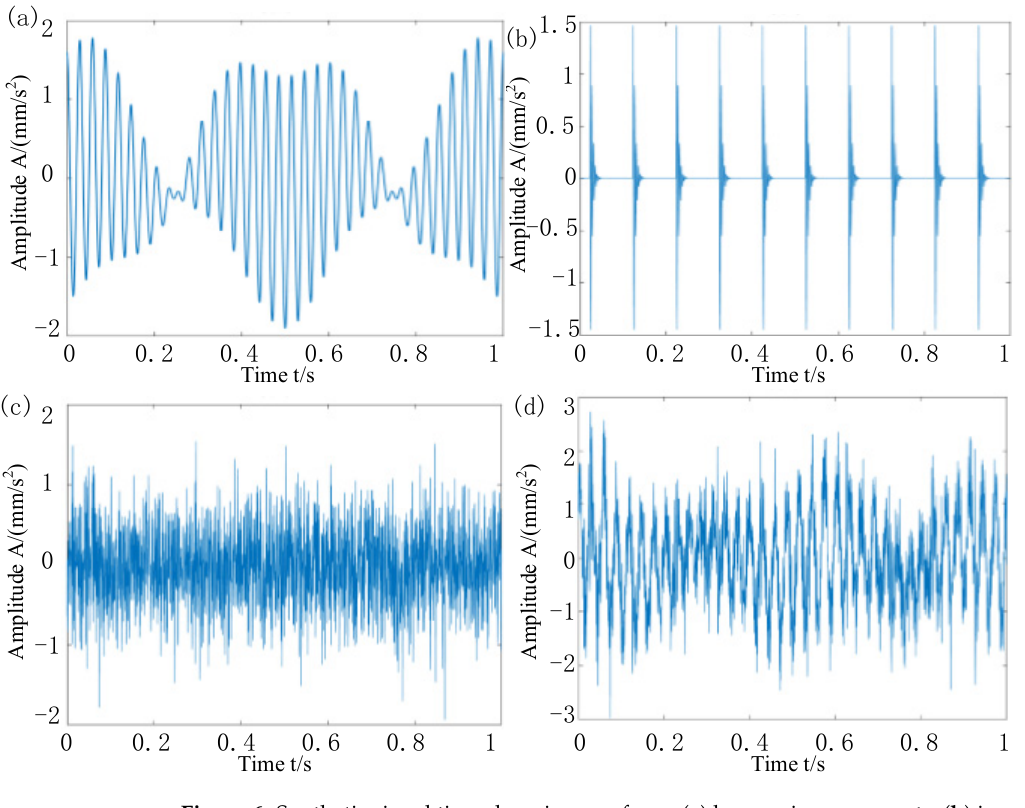
Figure 6. Synthetic signal time-domain waveform: ( a ) harmonic components; ( b ) impact component; ( c ) noise; ( d ) synthetic signal.